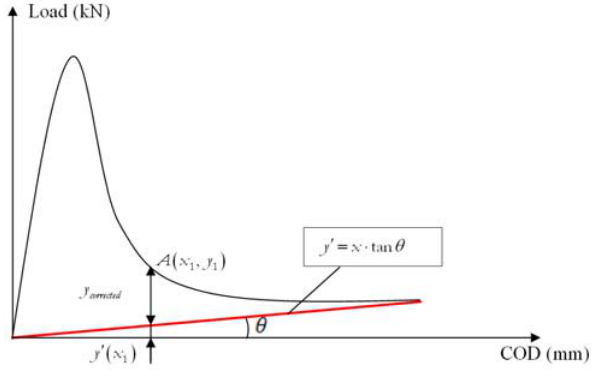
Figure 11: Scheme for the correction of the y